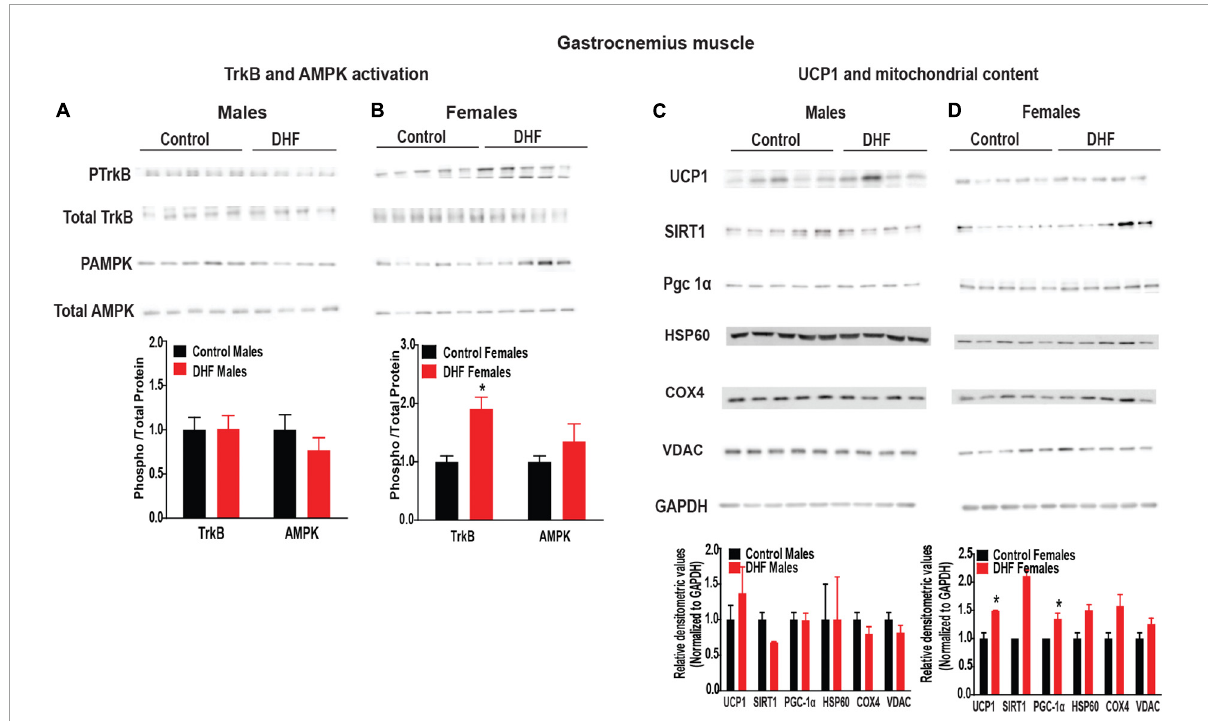
FIGURE5 7,8-DHF activates TrkB and UCP1 in gastrocnemius muscle of females. (A,B) Expression and quantification of TrkB and AMPK activation in gastrocnemius muscle. (C,D) Expression and quantification of mitochondrial content markers in gastrocnemius muscle. Statistical analyses were carried out using student’s t -test. p -values < 0.05 were considered significant. Data are expressed as average ± SEM ( n = 5). * p < 0.05 vs. sex-and treatment-matched